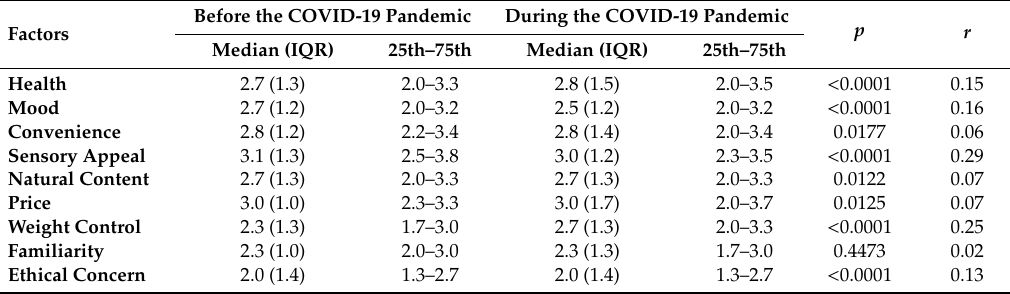
Table 5. The factors influencing food choice based on the applied Food Choice Questionnaire (FCQ) for the period before and during the COVID-19 pandemic for the sample of adolescents studied within the PLACE-19 Study ( n = 2448).